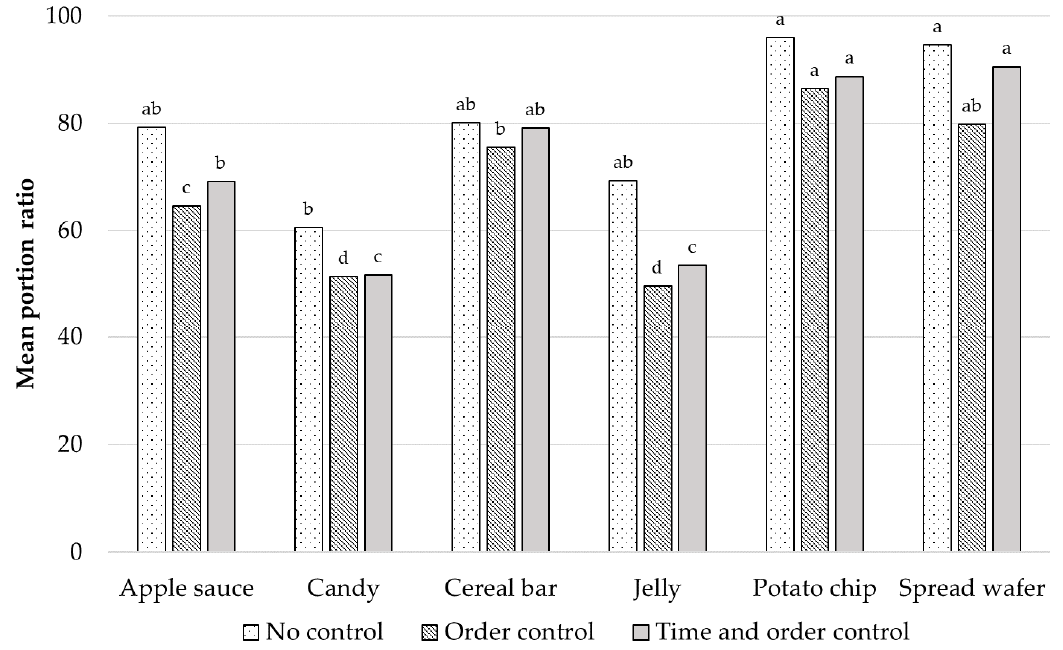
Figure 4. Adequate portion size evaluated by consumers. Adequate portion size was presented as an open-ended question (written down as the ratio value compared to the provided sample amount as 100). There are no significant differences between groups; samples sharing the same letter at the top of bars means no significant differences within each group ( α = 0.05). Table 11. The amount of consumption evaluated by